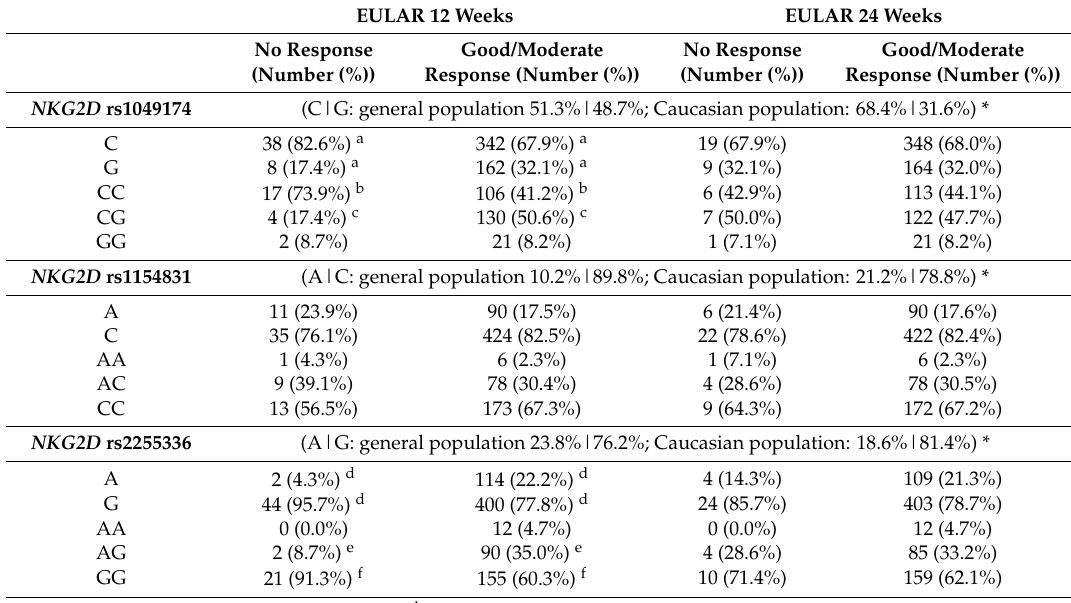
Table 2. Relationships of the NKG2D gene polymorphisms with EULAR responses at 12 and 24 weeks of anti-TNF therapy. EULAR 12 Weeks EULAR 24 Weeks No Response Good/Moderate No Response (Number (%)) Response (Number (%)) (Number